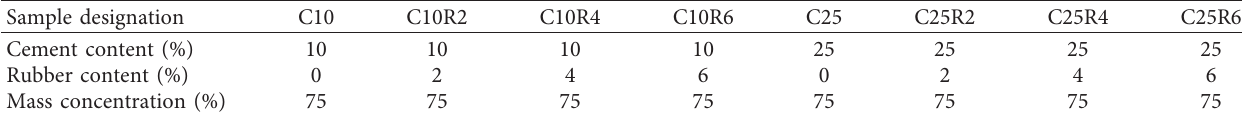
Table 2: Designation and mix proportions of cemented tailings samples used in this